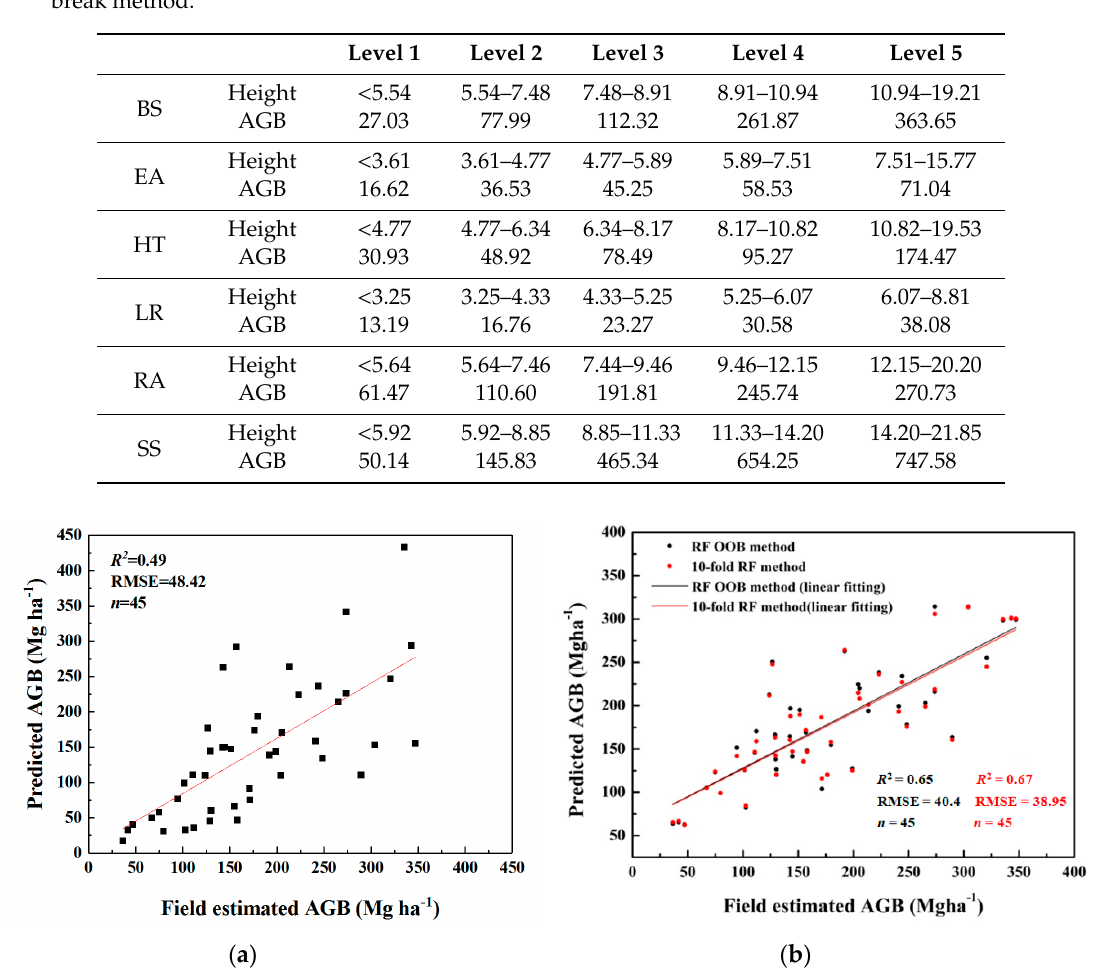
Table 8. AGB density of different mangrove species in five height levels (Height: m; AGB: Mg ha − 1 ). The division of five height levels for each species is based on all this type of trees using the nature break method.